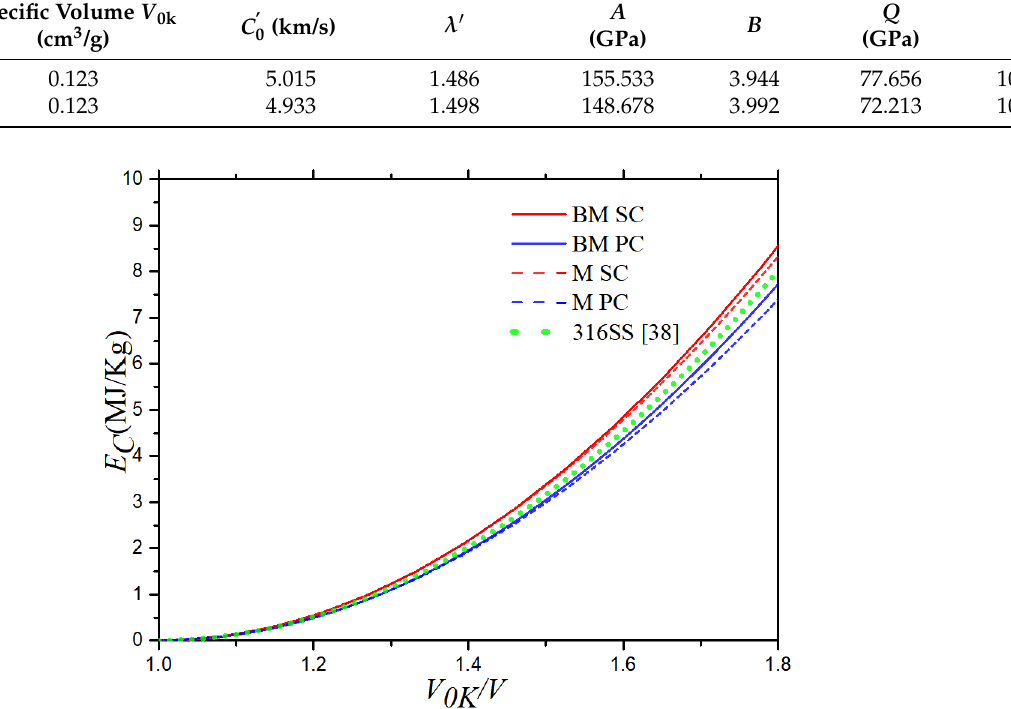
Figure 5. Cold energy curves of SC and PC 316 stainless steel.